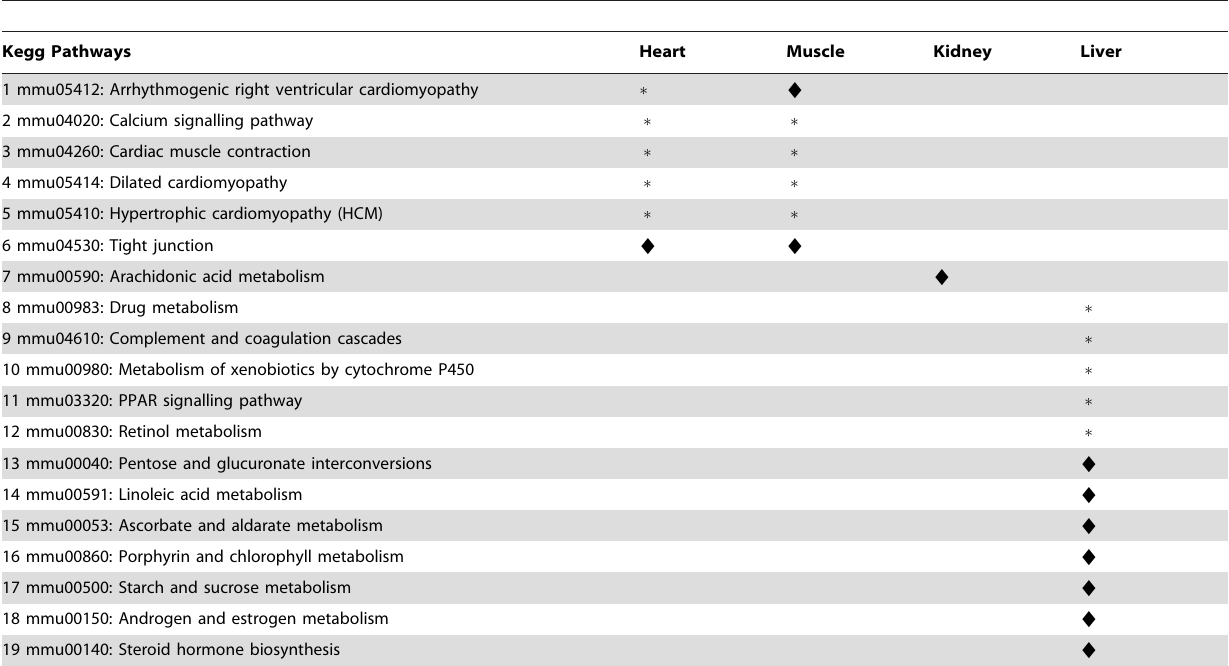
Table 5. Enrichment of KEGG pathways in the four tissue specific gene clusters.